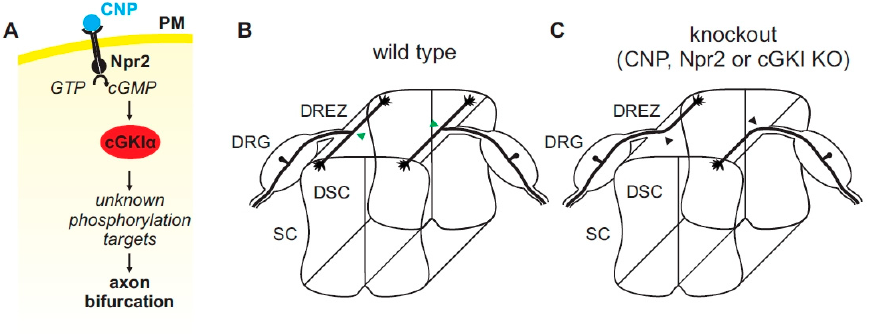
Figure 4. ( A ) A cGMP (cyclic guanosine monophosphate)-dependent signaling cascade composed of CNP, Npr2, and cGKI (cGMP-dependent protein kinase I) is implicated in the bifurcation of sensory axons. In the absence of any of these components sensory axons do not bifurcate when entering the spinal cord or the hindbrain (please compare ( B , C ) for the wild type and the knockout situation, respectively). Arrow heads in green ( B ) point to the bifurcation of sensory axons in the wild type and arrow heads in black ( C ) point to bifurcation errors in knockouts of CNP , Npr2 or cGKI . The downstream phosphorylation targets of cGKI involved in axon bifurcation have not been defined yet. DRG, dorsal root ganglion; DREZ, dorsal root entry zone; DSC, dorsal spinal cord; SC, spinal